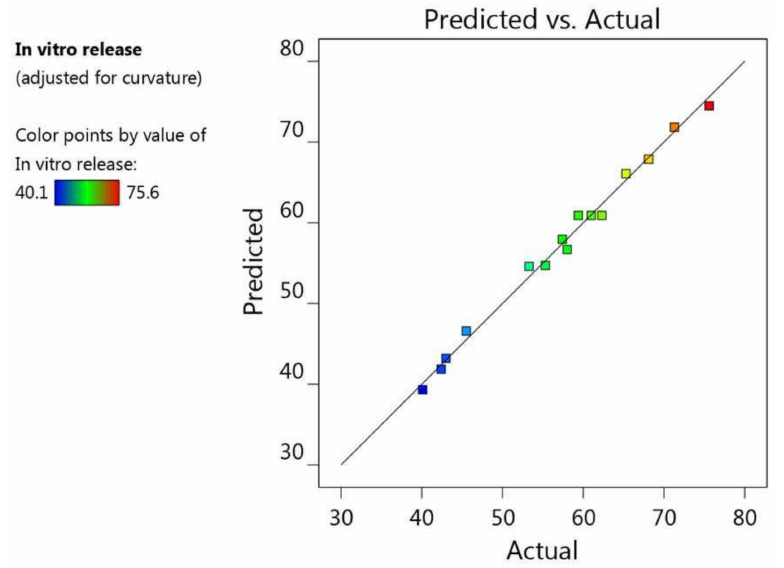
Figure 7. Predicted versus actual plot representing the linear correlation between values for in vitro release response (R 2 ).